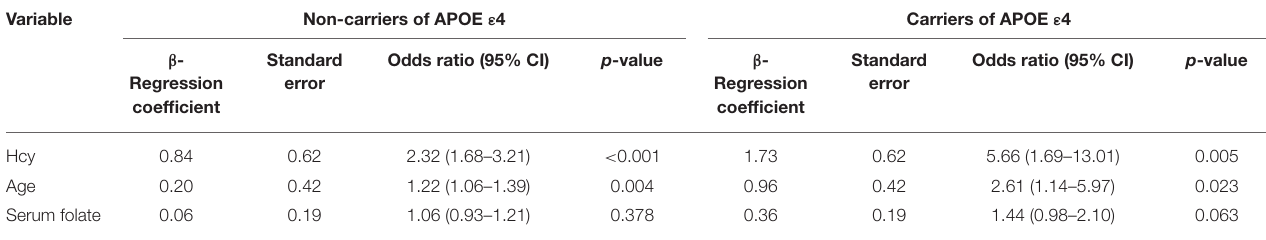
TABLE 3 | Associations of homocysteine levels with MTA scores of the carriers and non-carriers of APOE ε 4 among aMCI patients.